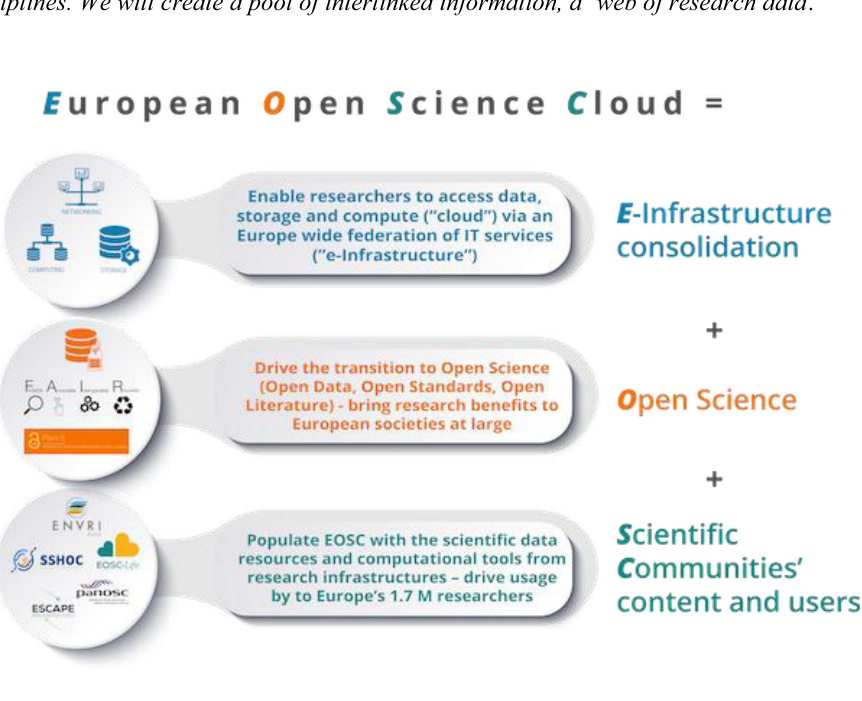
Figure 1 : ESFRI thematic cluster view on EOSC. Source: Blomberg, Niklas, & Petzold, Andreas. (2020, January 30). ESFRI thematic cluster view on EOSC.